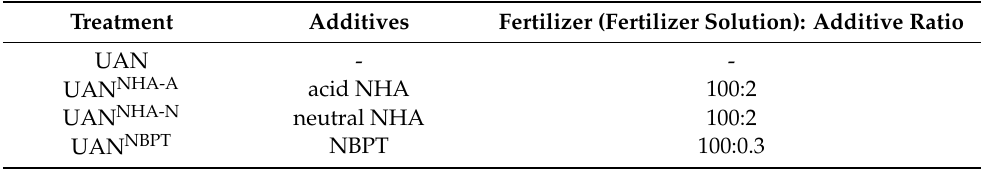
Table 6. Treatments of the greenhouse experiment. Treatment Additives Fertilizer (Fertilizer Solution): Additive Ratio